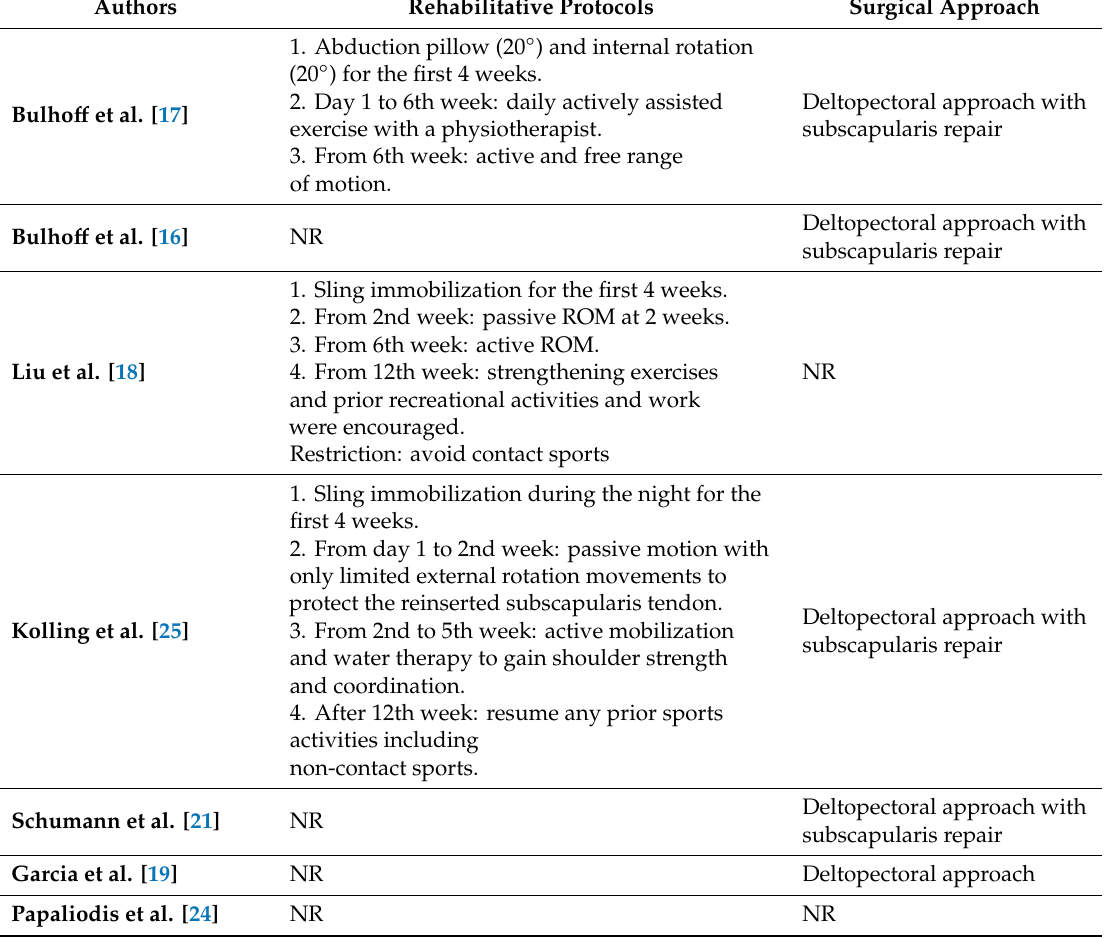
Table 4. Rehabilitative protocols and surgical